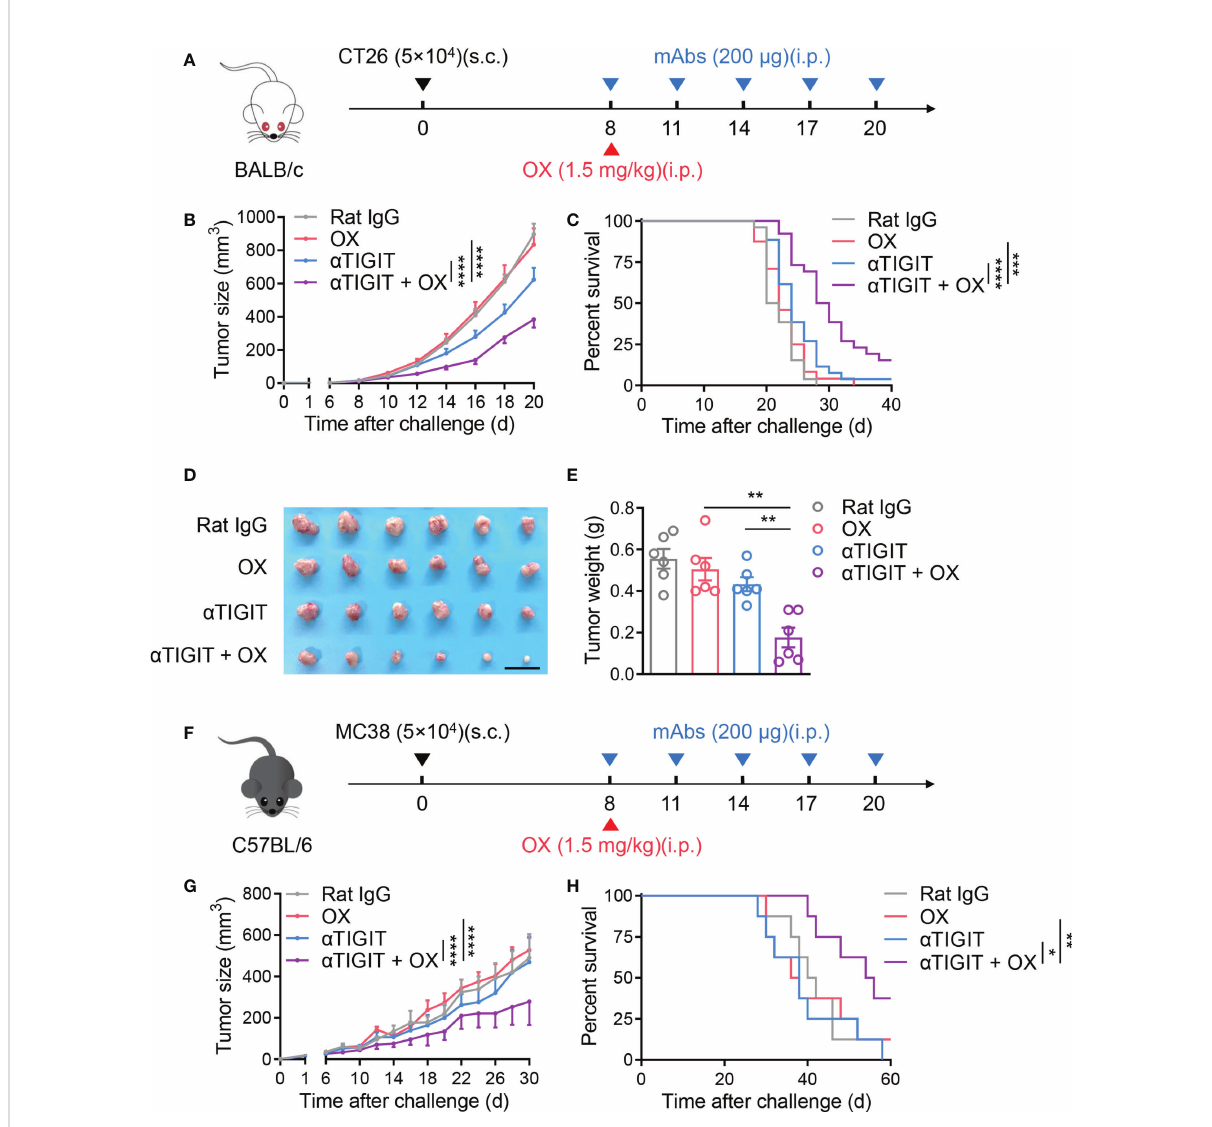
FIGURE 1 Low-dose oxaliplatin improves colon cancer immunotherapy of anti-TIGIT mAb. (A) , Experimental scheme for CT26 colon cancer model used in (B – E) . Mice were given injection of Rat IgG, anti-TIGIT mAb (10 mg/kg), oxaliplatin (OX, 1.5 mg/kg) or anti-TIGIT mAb plus OX intraperitoneally (i.p.) at various times after injection of 5×10 4 CT26 tumor cells subcutaneously (s.c.) on day 0. (B) , Tumor size measurement at each time point. (n=16- 20 mice per group). (C) , Overall survival of CT26-bearing mice with various treatments. (D) , Representative photograph and (E) weight of tumor ( n = 6 per group) on day 21 after challenge. Scale bar represents 2 cm. (F) , Experimental scheme for MC38 colon cancer model used in (G, H) . Mice were given injection of Rat IgG, anti-TIGIT mAb, OX or anti-TIGIT mAb plus OX intraperitoneally (i.p.) at various times after injection of 5×10 4 MC38 tumor cells subcutaneously (s.c.) on day 0. (G) . Tumor size measurement at each time point. (n=6-8 mice per group) (H) , Overall survival of MC38-bearing mice with various treatments. Data were representative of at least two independent experiments. Error bars represent means ± SEM. Statistical signi fi cance was determined using two-way ANNOVA (B, G) , Mantel – Cox test (C, H) or one-way ANOVA followed by Tukey ’ s multiple-comparisons (E) . *p < 0.05; **p < 0.01; ***p < 0.001 and ****p <